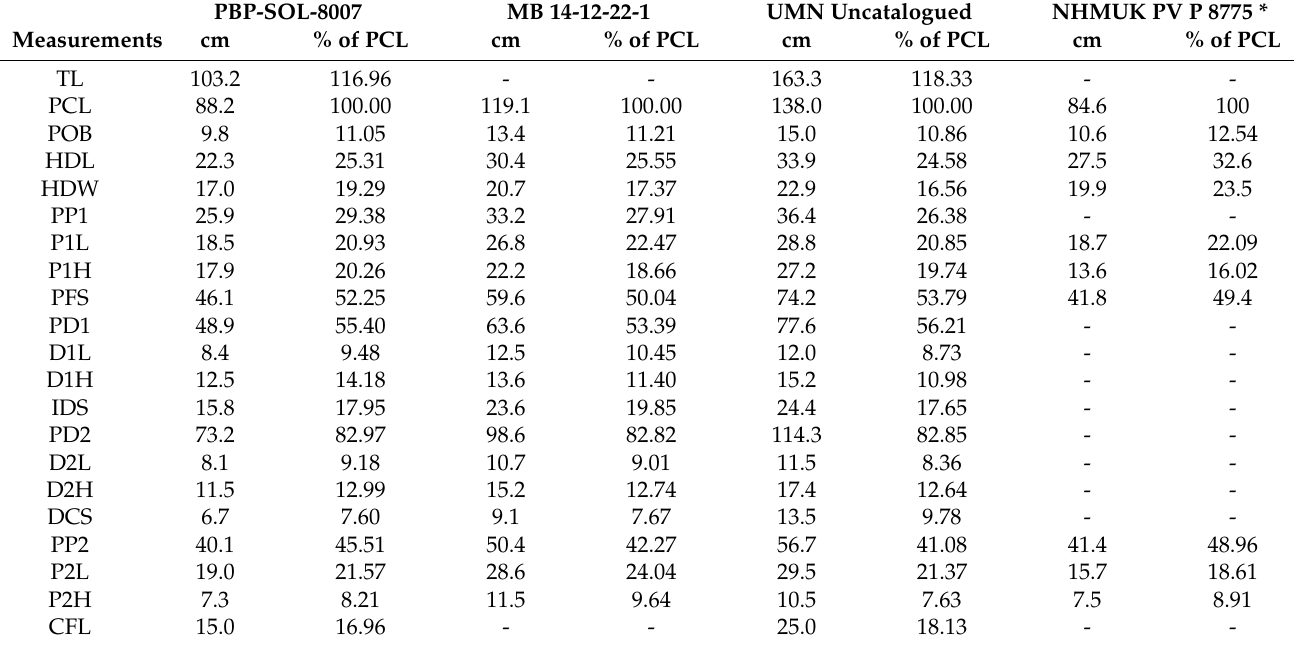
Table 1. Morphometric data for three well-preserved specimens (PBP-SOL-8007, MB 14-12-22-1, UMN uncatalogued) and the holotype (NHMUK PV P 8775) of Protospinax annectans Woodward, 1918 from the lower Tithonian of the Solnhofen Archipelago, Bavaria, Germany. Measurements followed Compagno [72] and are summarized in Figure 2. Abbreviations : CFL , caudal fin length; D1H , first dorsal height; D2H , second dorsal height; D1L , first dorsal length; D2L , second dorsal length; DCS